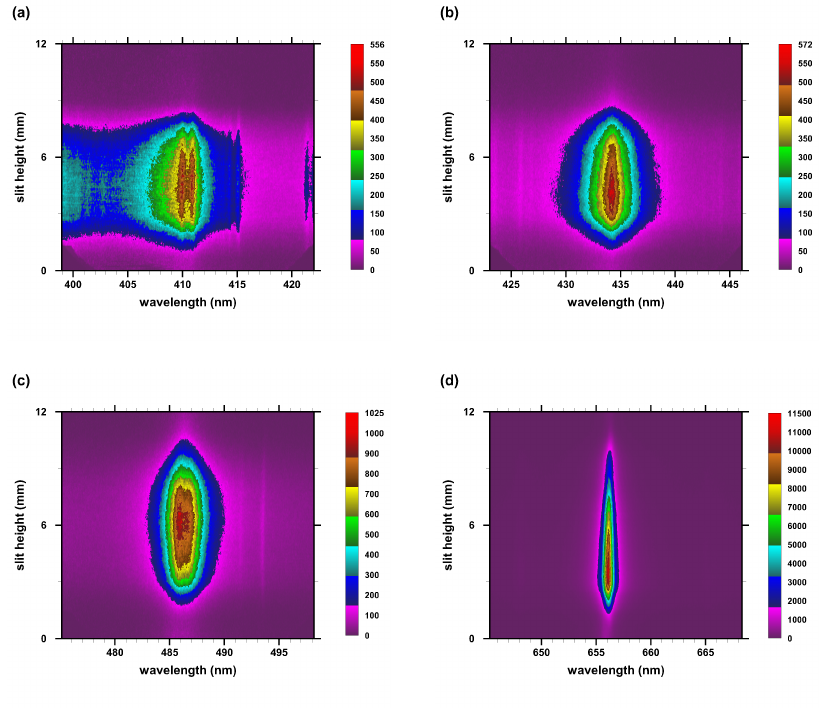
Figure 4. Recorded Balmer-series hydrogen lines at 3.25- µ s time delay, 0.025- µ s gate. ( a ) H δ , ( b ) H γ , ( c ) H β , and ( d ) H α